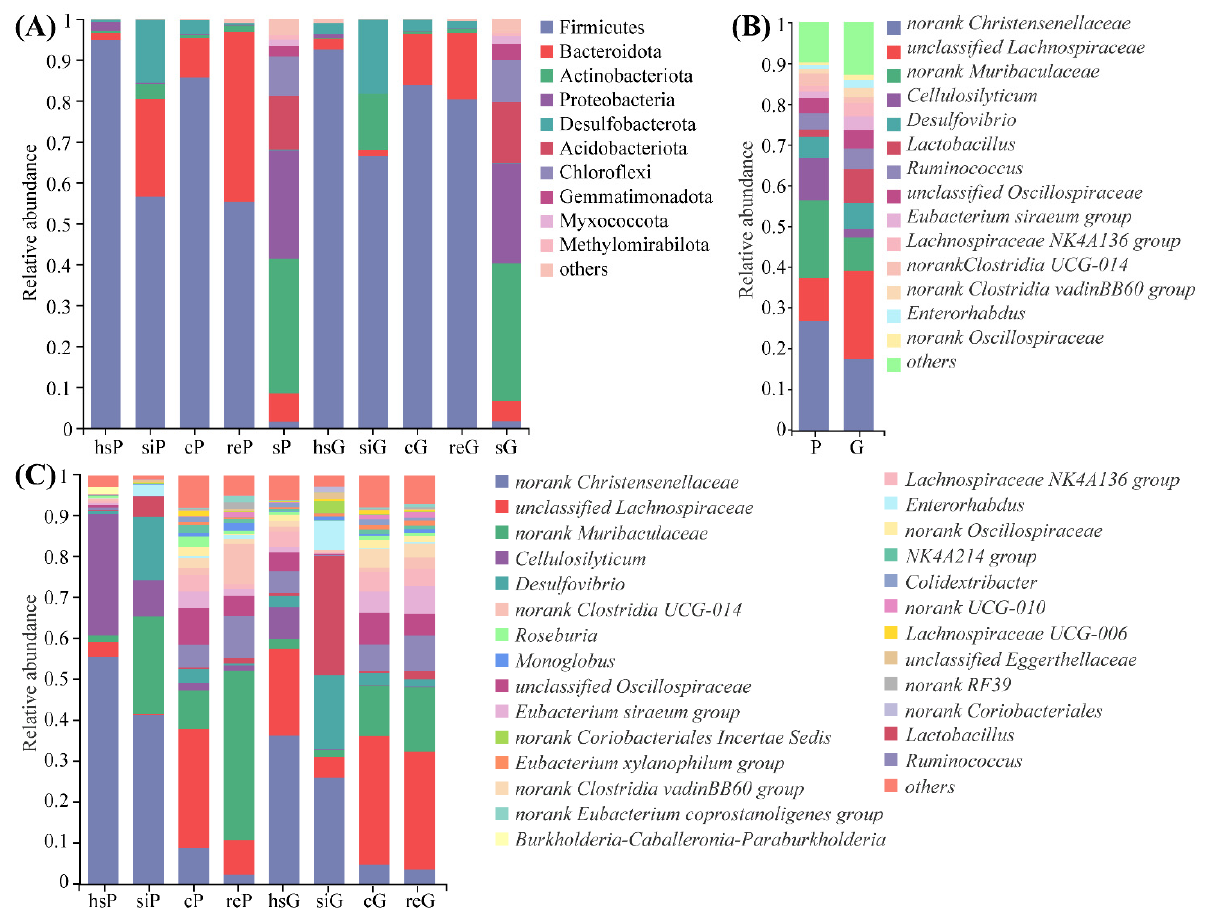
Figure 4. Relative abundance histograms at the phylum level ( A ). Relative abundance histograms at the genus level for plateau and Gansu zokors ( B ). Relative abundance histograms at the genus level for different GIT segments of plateau and Gansu zokors ( C ). “Others” represents the phyla with a relative abundance of less than 1%. P represents the plateau zokor and G represents the Gansu zokor. The stomach, small intestine, cecum, rectum, and tunnel soil of the plateau zokor (the Gansu zokor) are labeled as h sP, siP, cP, reP, and sP ( h sG, siG, cG, reG, and sG ) , respectively.